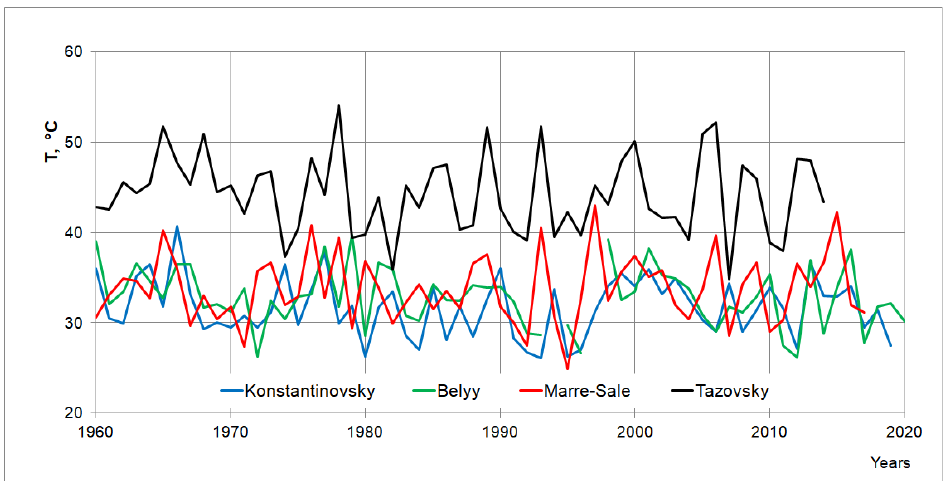
Figure 3. Changes in the annual amplitude of air temperature by weather stations in northern Rus-